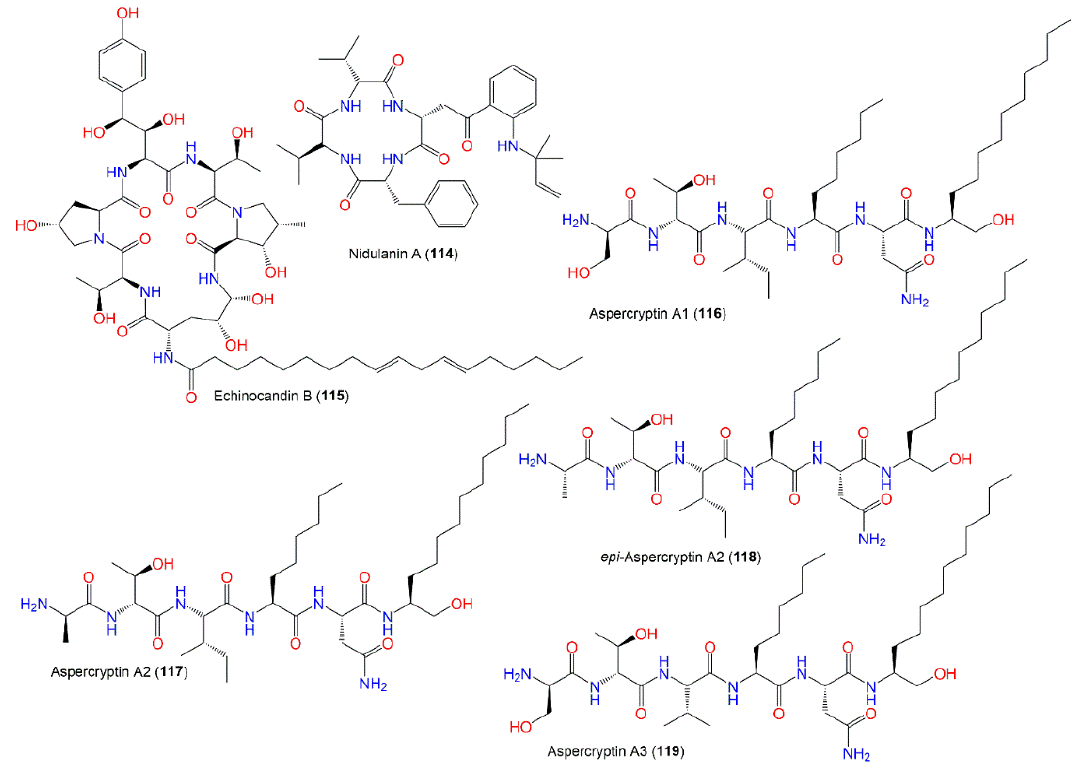
Figure 11. Structures of peptides ( 114 – 119 ).